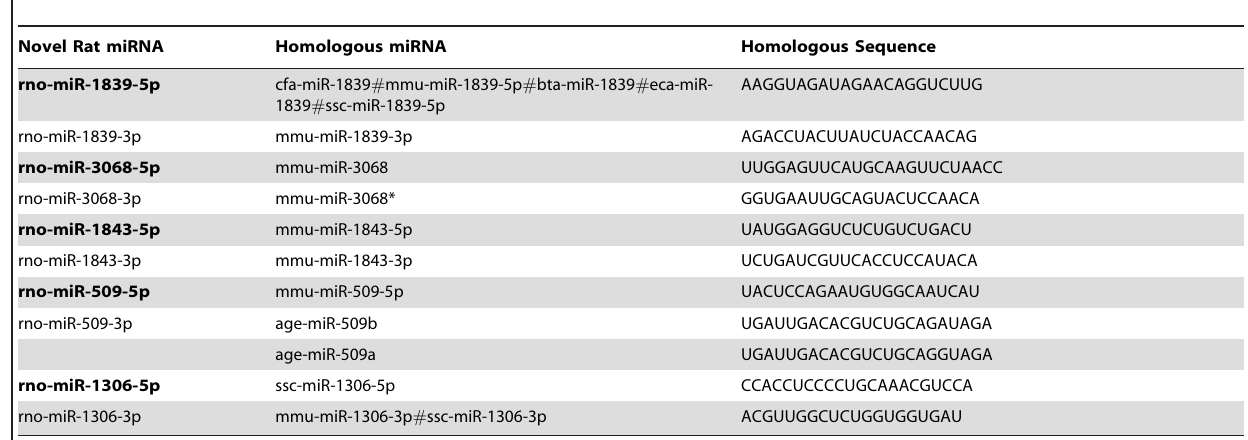
Table 2. Homologous miRNAs and homologous sequences related to ten novel rat homologous miRNAs.